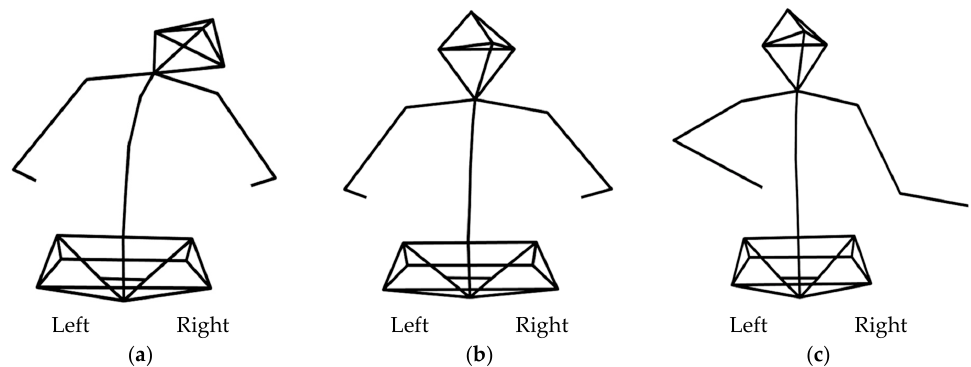
Figure 4. This figure shows spine lateral flexion of each condition. It is the posterior-anterior view of the participant during intervention. ( a ) Left mirror condition, ( b ) left screen condition, ( c ) left movable condition.